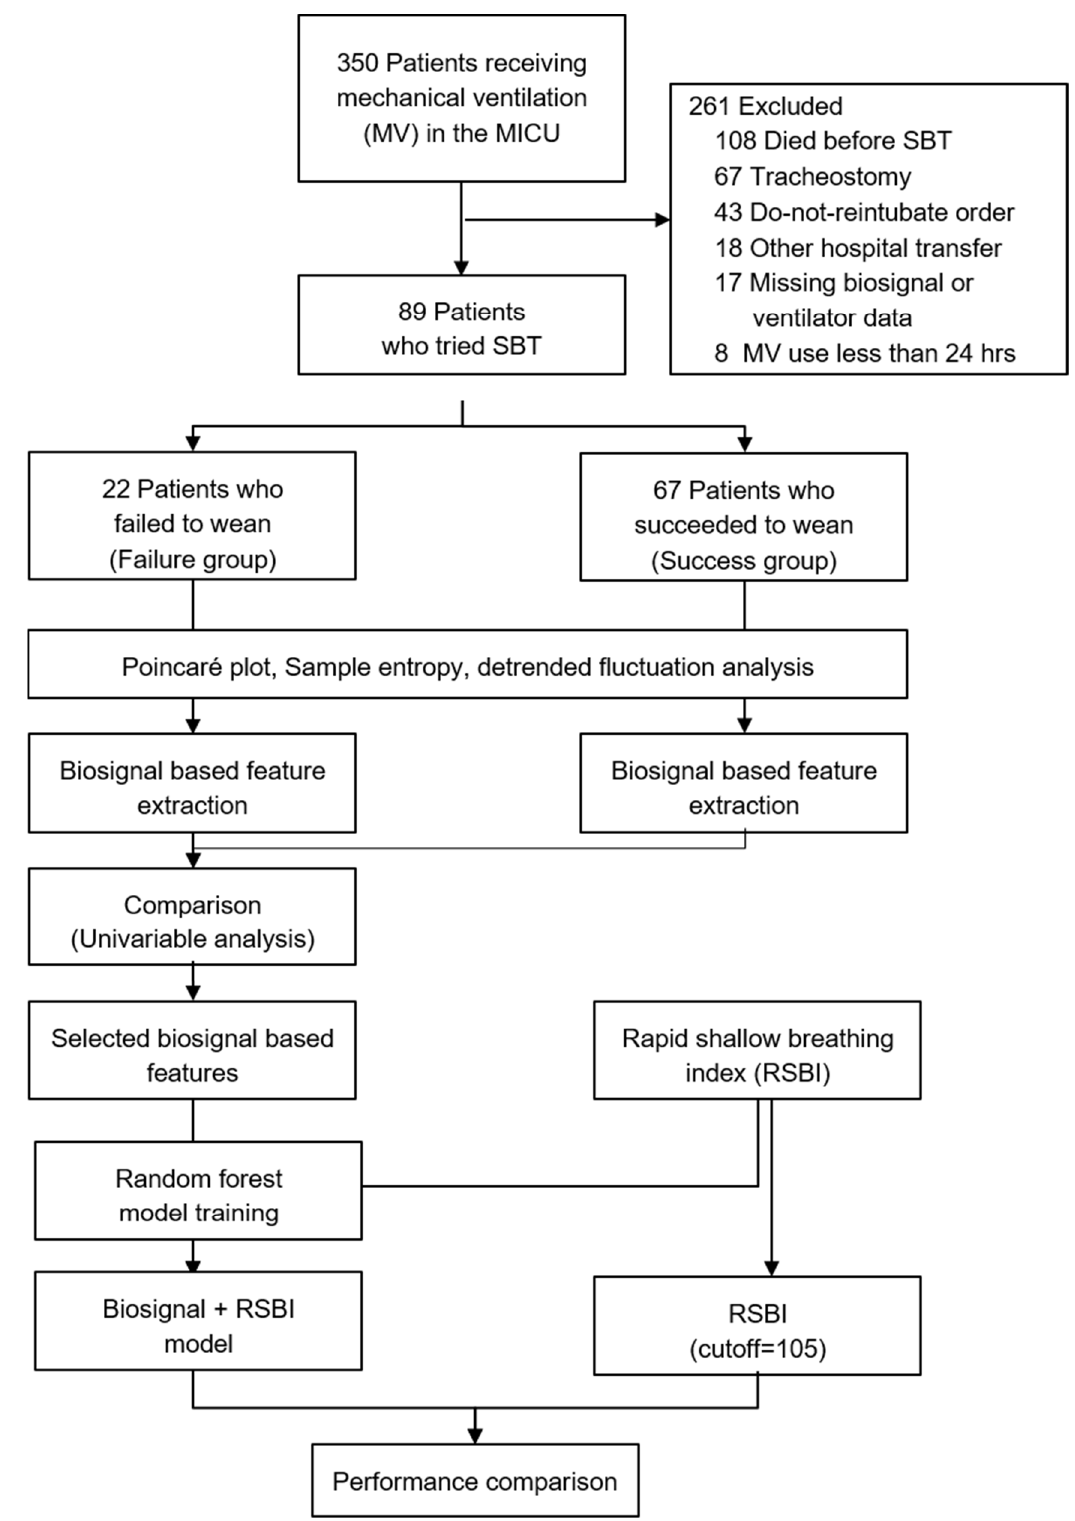
Figure 2. Study overview. We selected biosignal-based features that showed differences between the weaning failure and success groups. Their usefulness was evaluated by applying these features to predict weaning success, followed by comparison with the pre-existing RSBI. ICU, intensive care unit; RSBI, rapid shallow breading index; SBT, spontaneous breathing trial. tion and positive end-expiratory pressure; the FiO 2 remained unchanged from the MV